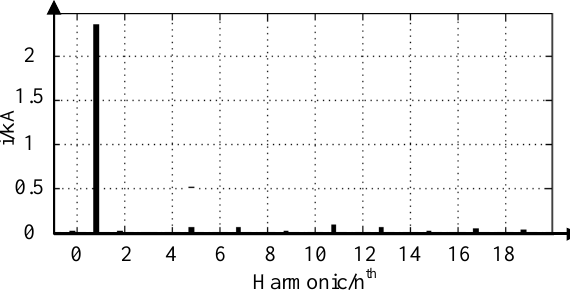
Figure 10. Low-order harmonic analysis of input current of ice-melting rectifier.